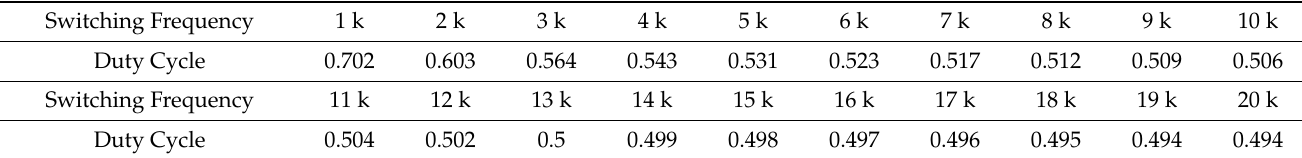
Figure 9. Variation of average equalizing current with switching frequency.